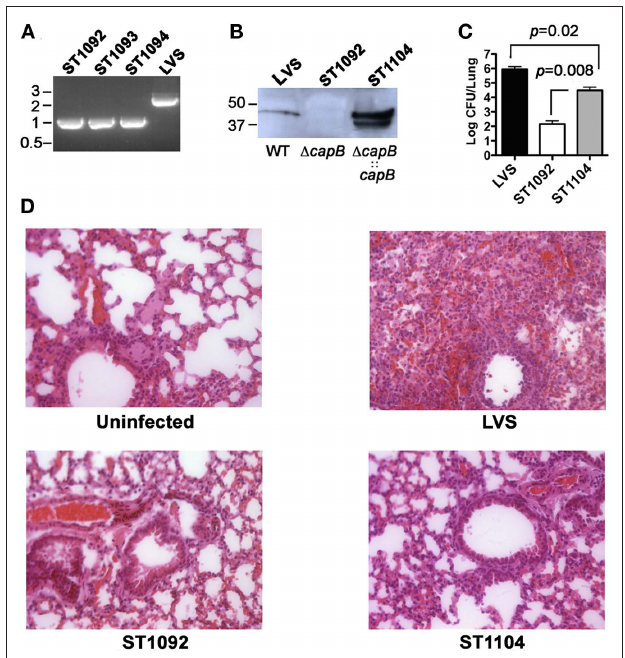
Figure 3 | CapB expression and its impact on in vivo growth of F. tularensis. (A) Detection of the capB deletion by PCR. The sequence surrounding the capB gene was amplified from the genomic DNA of LVS or three isogenic ∆ capB clones (ST1092-4). The PCR products were separated in a 1% agarose gel and stained with ethidium bromide. The sizes of the DNA standards are indicated in kilobase. (B) Western blot detection of the F. tularensis CapB. Cell lysates of LVS derivatives representing ∼ 2 × 10 9 CFUs were separated by SDS-PAGE, probed with the GST-CapB antiserum, and detected by an ECL method. (C) In vivo growth of the F. tularensis ∆ capB mutant. BALB/c mice were infected individually with LVS (4,500